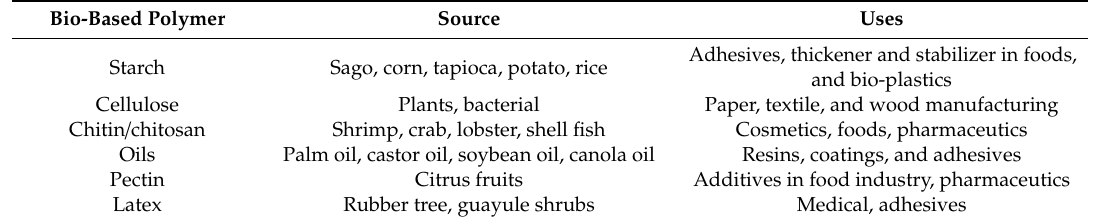
Table 1. Various types of bio-based polymers, their sources, and uses